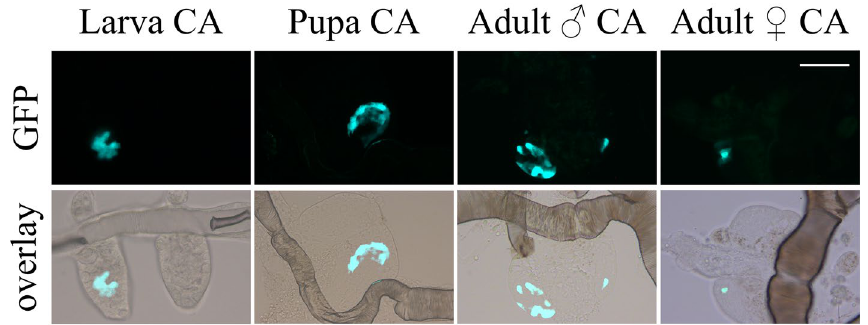
Figure 5. Stage-specific expression of eGFP. Fluorescent microscopy was employed to detect eGFP in the CA at all stages of the mosquito life cycle. Individual eGFP-positive CA were observed through the cuticle of larvae. Afterward, CA were dissected from late 4th instar larva, pupa, or adults to analyze in detail the presence of eGFP. eGFP was present only in some cells of the CA. Autofluorescence was detected neither in the CA of WT nor in most cells of the CA of mutants. Scale bar, 50